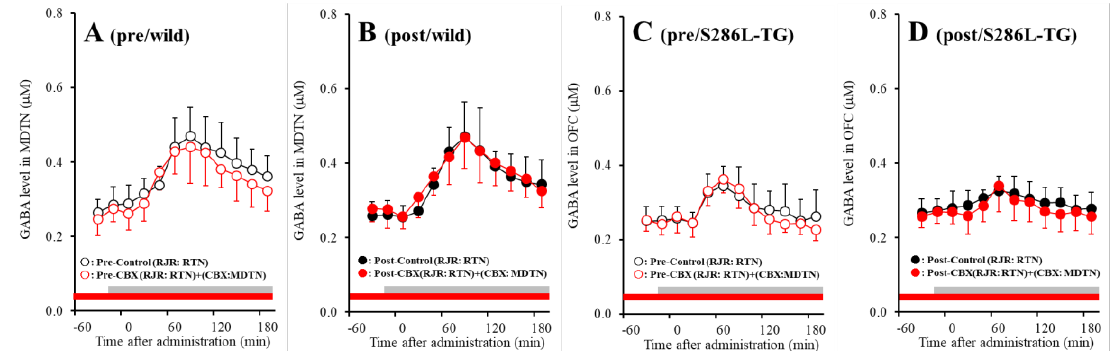
Figure 8. E ff ects of local administration of 100 µ M CBX (non-selective hemichannel inhibitor) into the MDTN on pre-RJR- (panels A , C ) and post-RJR-evoked (panels B , D ) GABA release (before and after hemichannel activation induced by perfusion with FCHK-MRS into the MDTN for 20 min) in the MDTN of wild-type (panels A , B ) and S286L-TG (panels C , D ). Ordinates indicate mean extracellular GABA level ( µ M) (N = 6), and abscissas indicate time after RJR-evoked stimulations (min). Gray bars indicate the perfusion with 100 µ M RJR2403 into the RTN. Red bars indicate the perfusion with 100 µ M CBX into the MDTN.